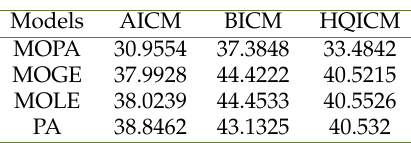
Table 6. The AICM, BICM, and HQICM values for Glass Fibers data.